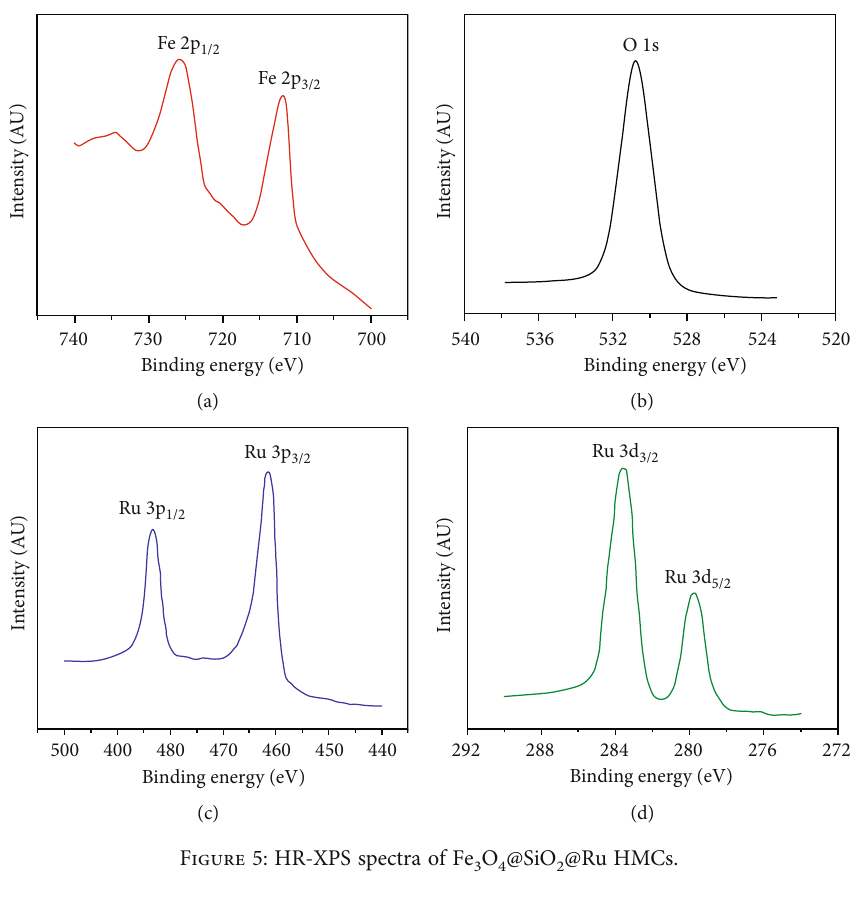
O @SiO @Ru HMCs. 3 4 2